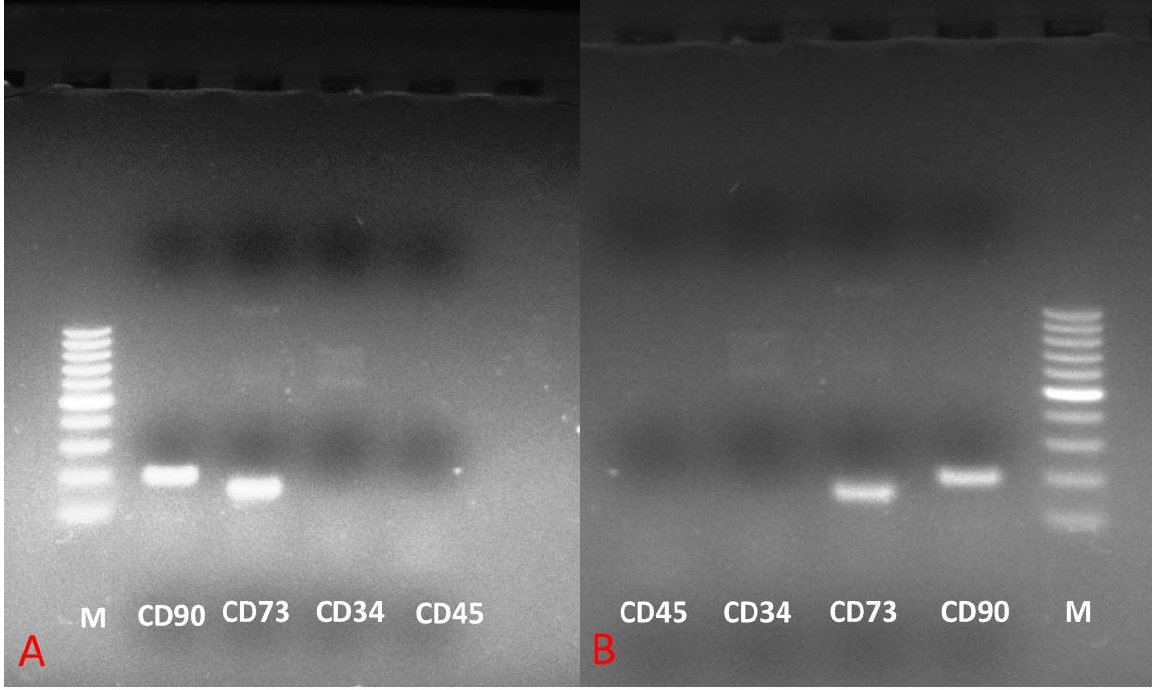
Figure 4. The expression analysis of genes of adipose tissue MSCs ( A ) and bone marrow MSCs ( B ) for different phenotypic markers. M: 50 bp Ladder. The phenotypic surface markers expressed are CD73 and CD90, while haematopoietic markers unexpressed were CD34 and CD45.